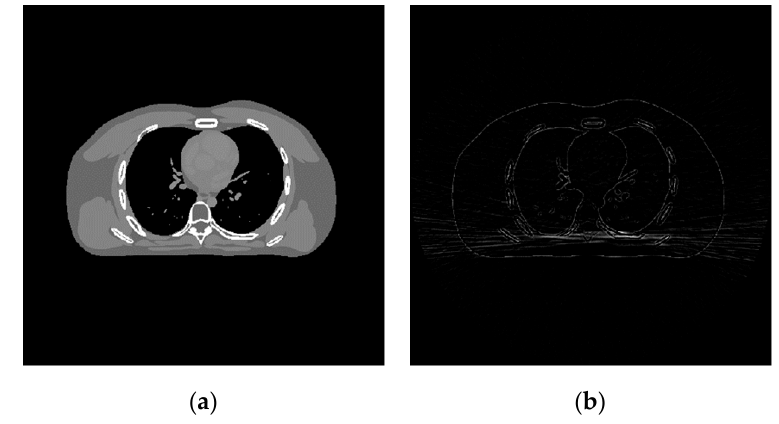
Figure 2. Flowchart of solving sparse transformation.